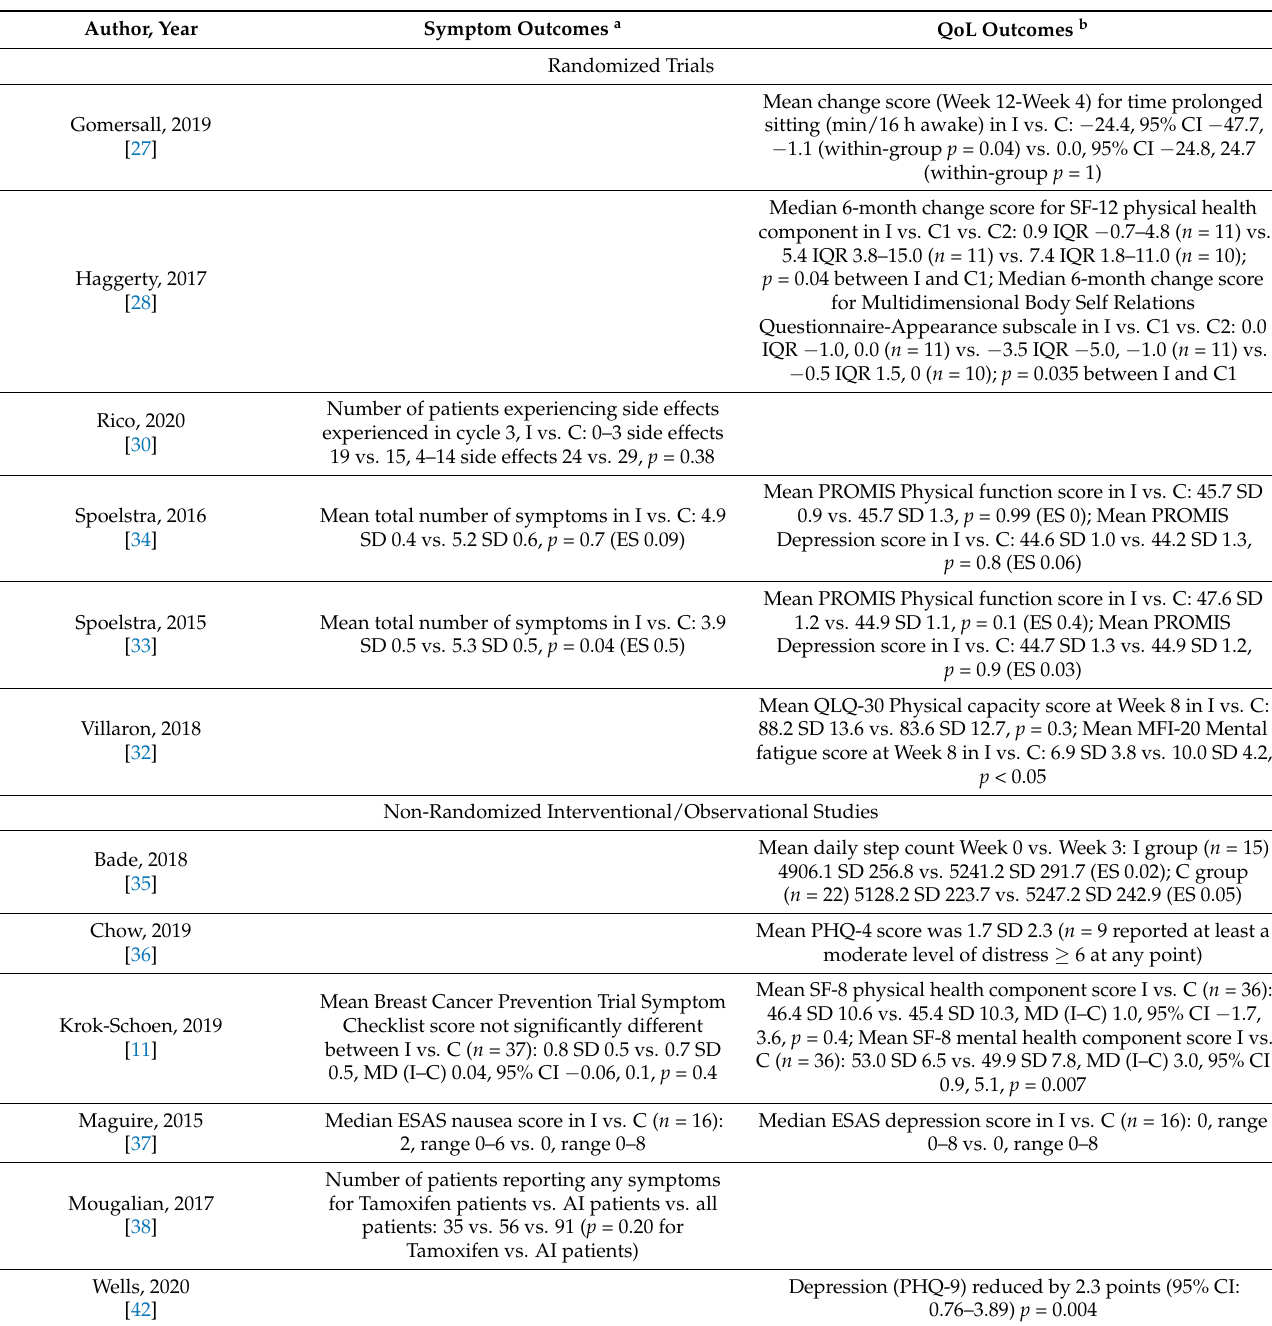
Table 3. Symptom ( n = 6 studies) and quality of life ( n = 10 studies) outcomes.